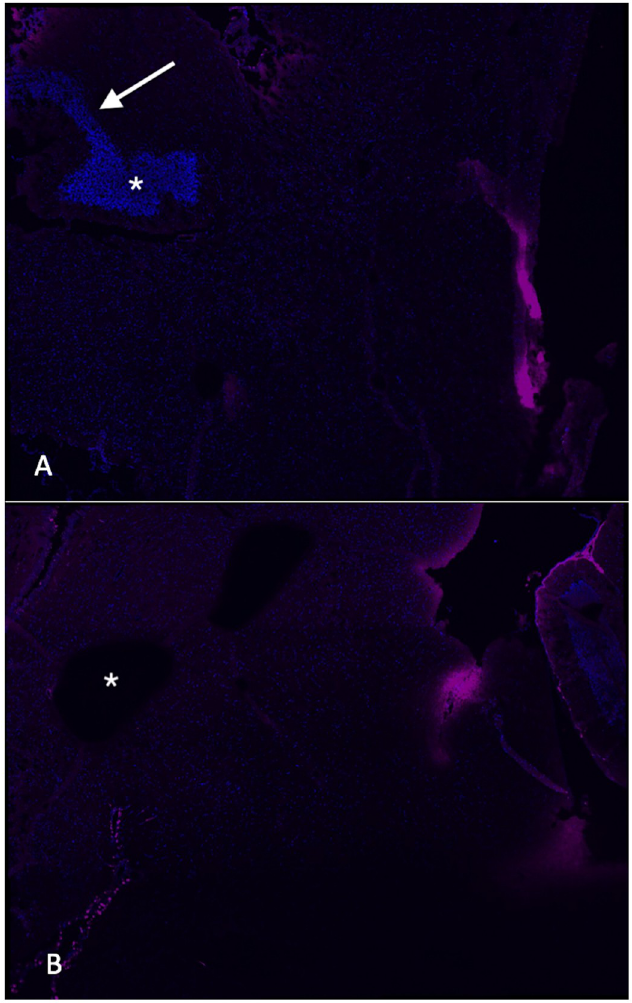
Fig 1. Evaluation of fluorescent tracer injection. A. Photomicrograph (20X magnification) of brain harvested after stereotaxic injection of labelled ovalbumin into the right lateral ventricle showing localized signal within the ventricle (asterisk) and along the injection track (arrow). B. Section from a control, uninjected animal demonstrating no staining in the ventricle (asterisk).